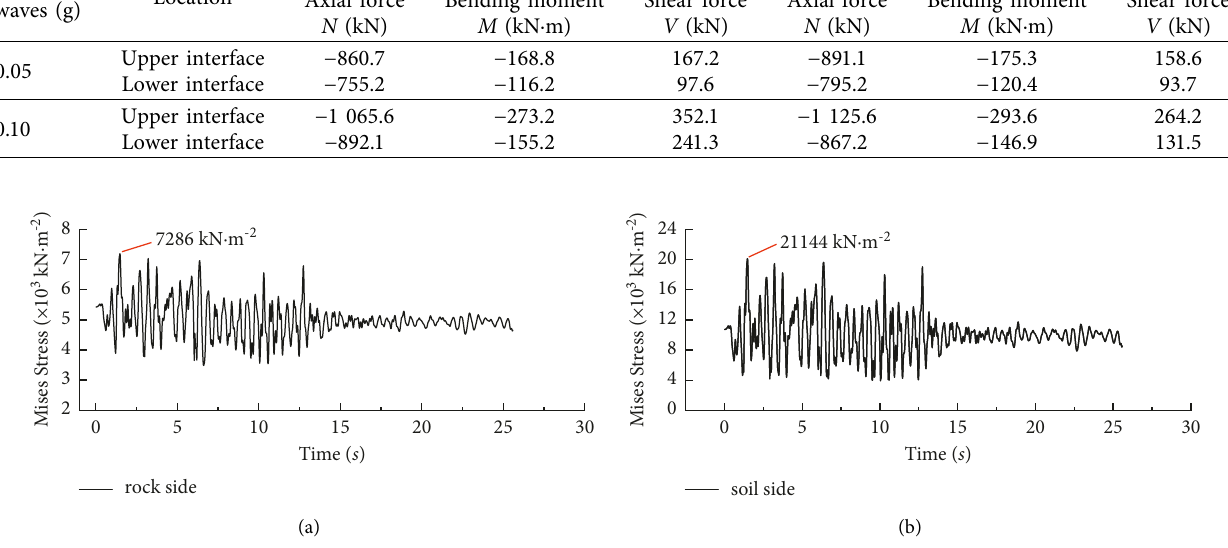
Figure 3: Time history curves of Mises stress at the soil-rock partition interface of the tunnel structure, (a) rock side of soil-rock partition interface of tunnel, and (b) soil side of the soil-rock partition interface of tunnel.